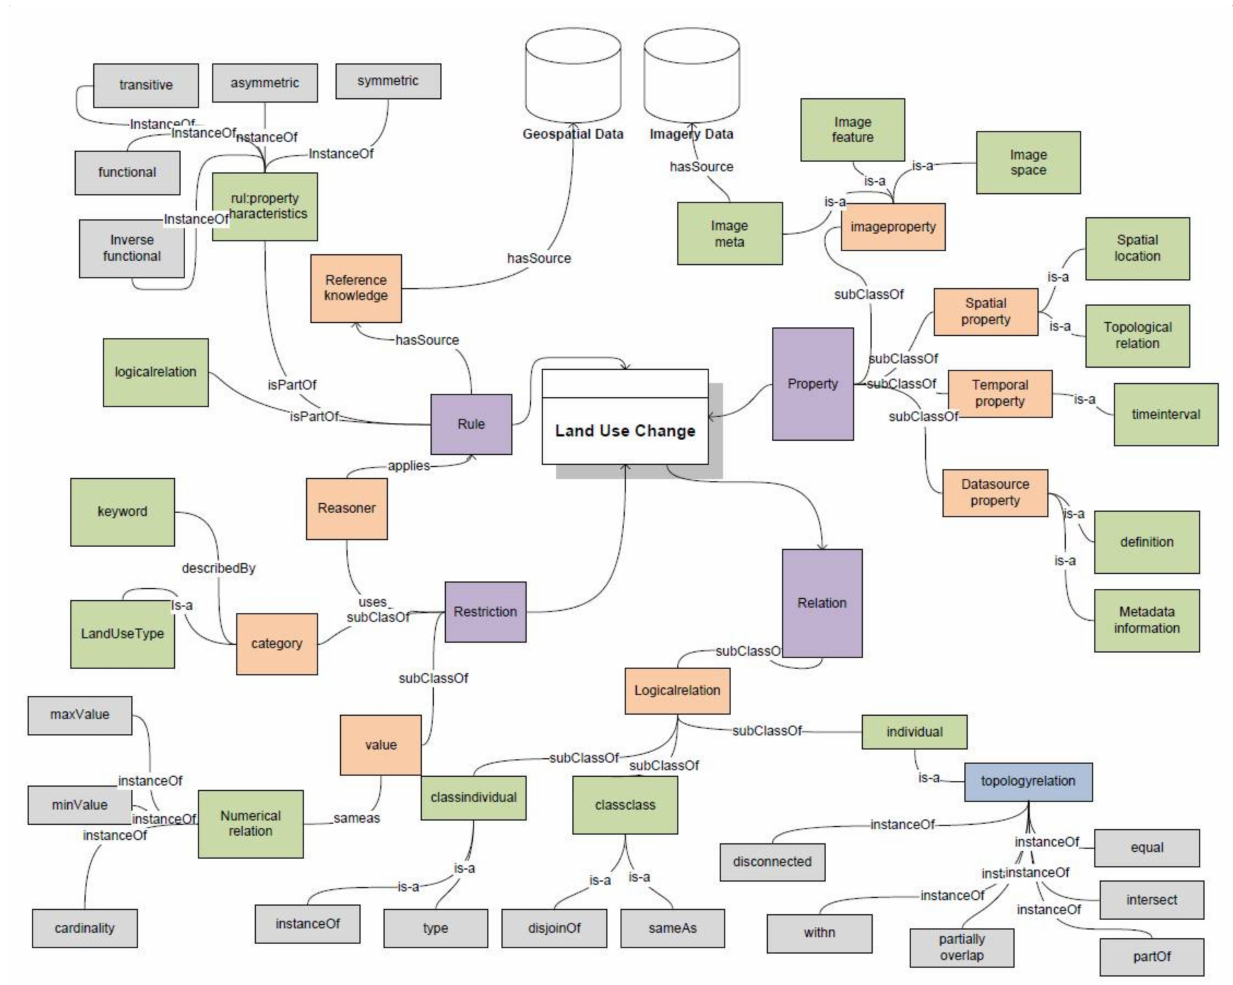
Figure 5. LUCO for land use change adapted with permission from [11], (2016, Li, W.). Nodes of the same color refer to the same